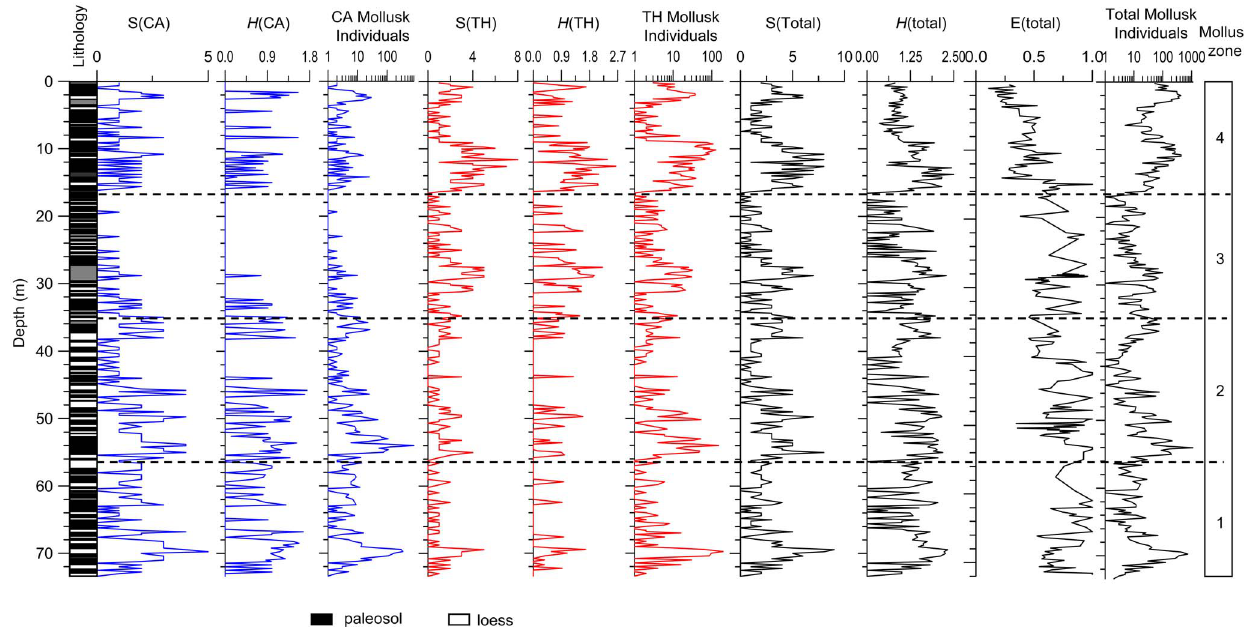
Figure 3. Variations in terrestrial mollusks versus depth in the Dongwan sequence. Lithology and total mollusk individuals are from Li et al., (2006a) [58] and Li et al. (2008) [47]. S(CA)–Total number of species of the cold-aridiphilous (CA) mollusk group. H (CA)–Diversity of the CA mollusk group. S(TH)–Total number of species of the thermo-humidiphilous (TH) mollusk group. H (TH)–Diversity of the TH mollusk group. S(total)–Total number of species of the total mollusk group. H (total)–Diversity of the total mollusk group. E(total)–Equitability of the total mollusk group.